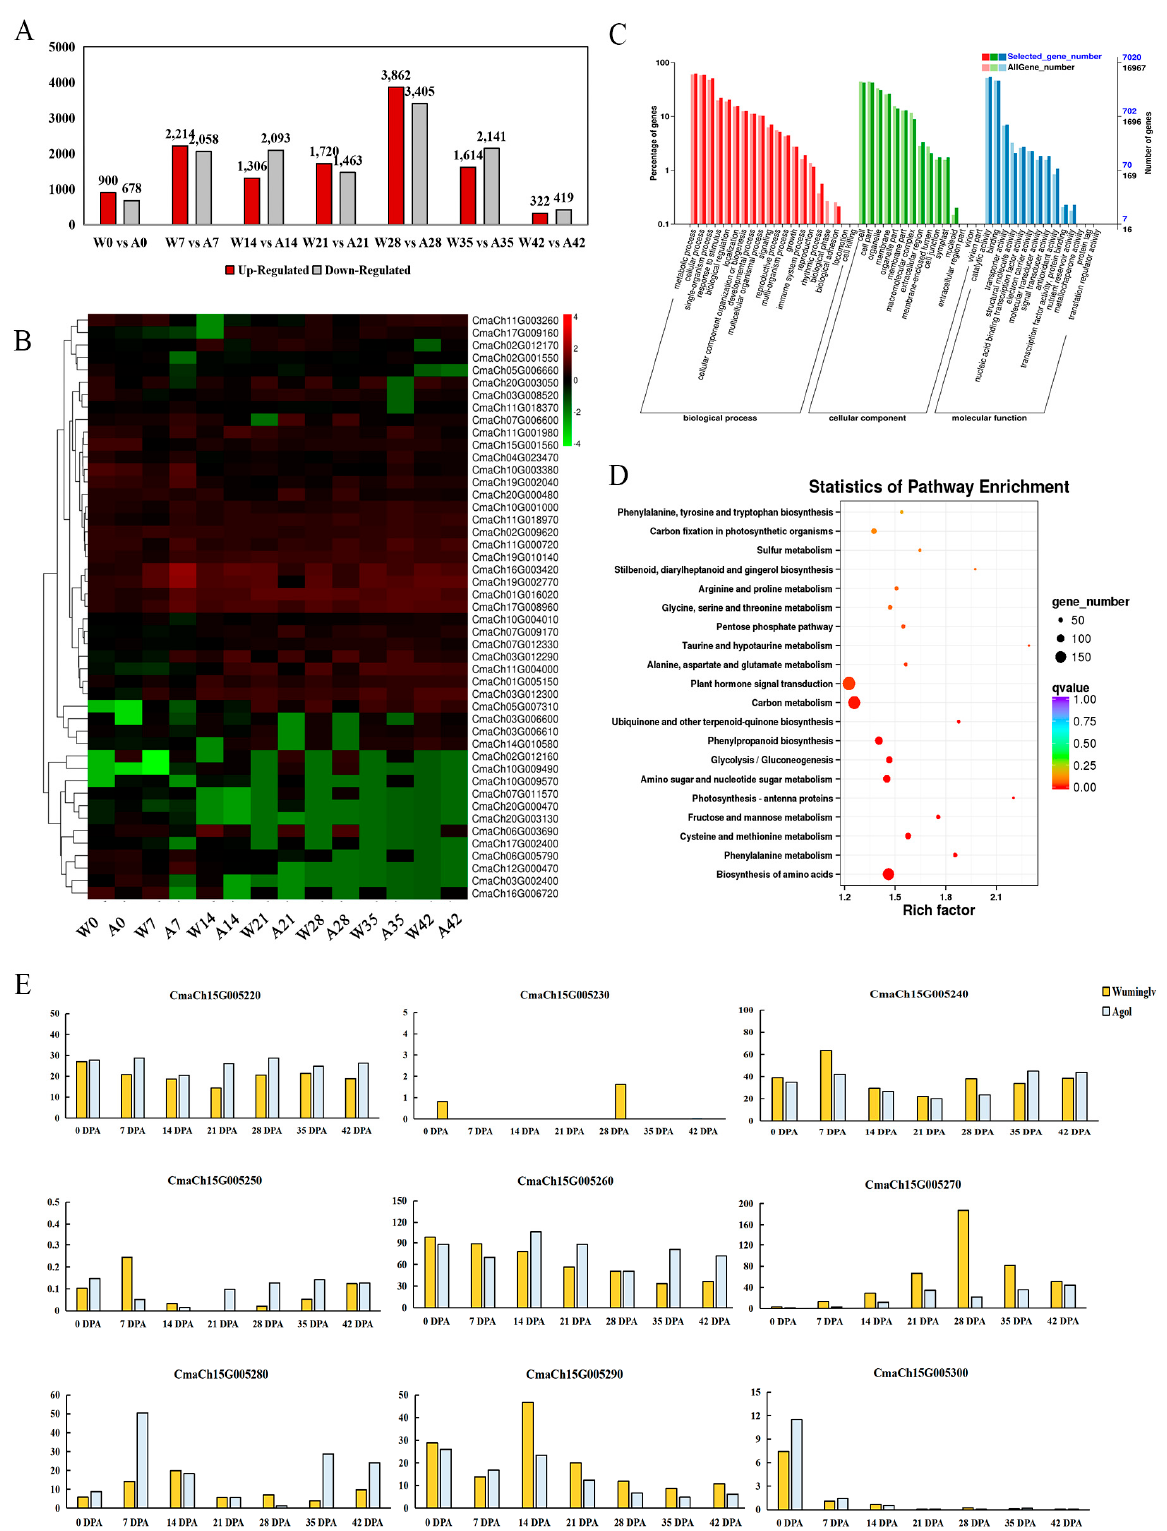
Figure 5. RNA-seq data analysis of phenylpropanoid/flavonoid metabolism pathway. ( A ) The amount of DEGs in different stages of seed coat development. ( B ) Heatmap of DEGs in phenylpropanoid/flavonoid metabolism pathway at 0~42 DPA seed coat. ( C ) GO enrichment analysis. ( D ) KEGG enrichment analysis. ( E ) Transcript expression levels in nine candidate genes in different stages of seed coat development in Wuminglv and Agol.